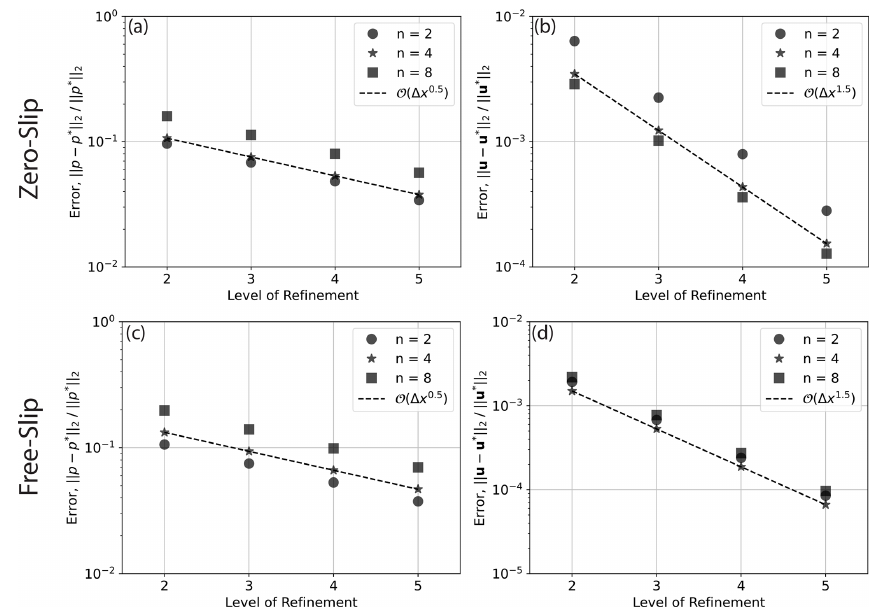
Figure A1. Convergence for 2-D cylindrical shell cases with zero-slip (a–b) and free-slip (c–d) boundary conditions using a Q2Q1 finite- element pair for the Stokes system, driven by a delta-function forcing at different wave numbers, n , as indicated in the legend (see Kramer et al., 2021a, for further details). Convergence rate is indicated by dashed lines, with the order of convergence provided in the legend. For the cases plotted, the series of meshes start at refinement level 1, where the mesh consists of 1024 divisions in the tangential direction and 64 radial layers. At each subsequent level the mesh is refined by doubling resolution in both directions.